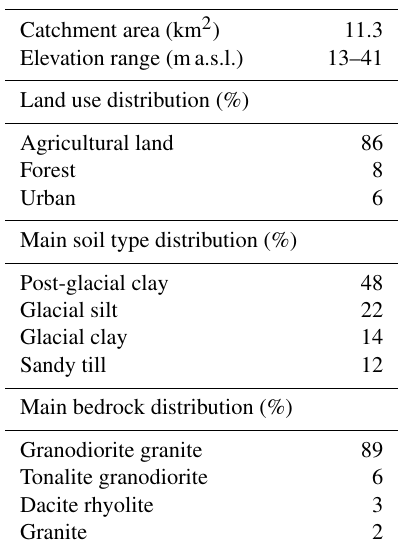
Table 1. Catchment characteristics of the Sundbromark (SBM) catchment.